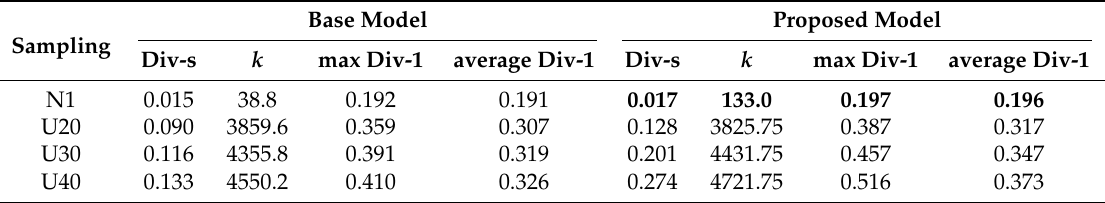
Table 2. Experimental results of the diversity of the base model and the proposed model. The result of the proposed method is more diverse than the base model is with N1